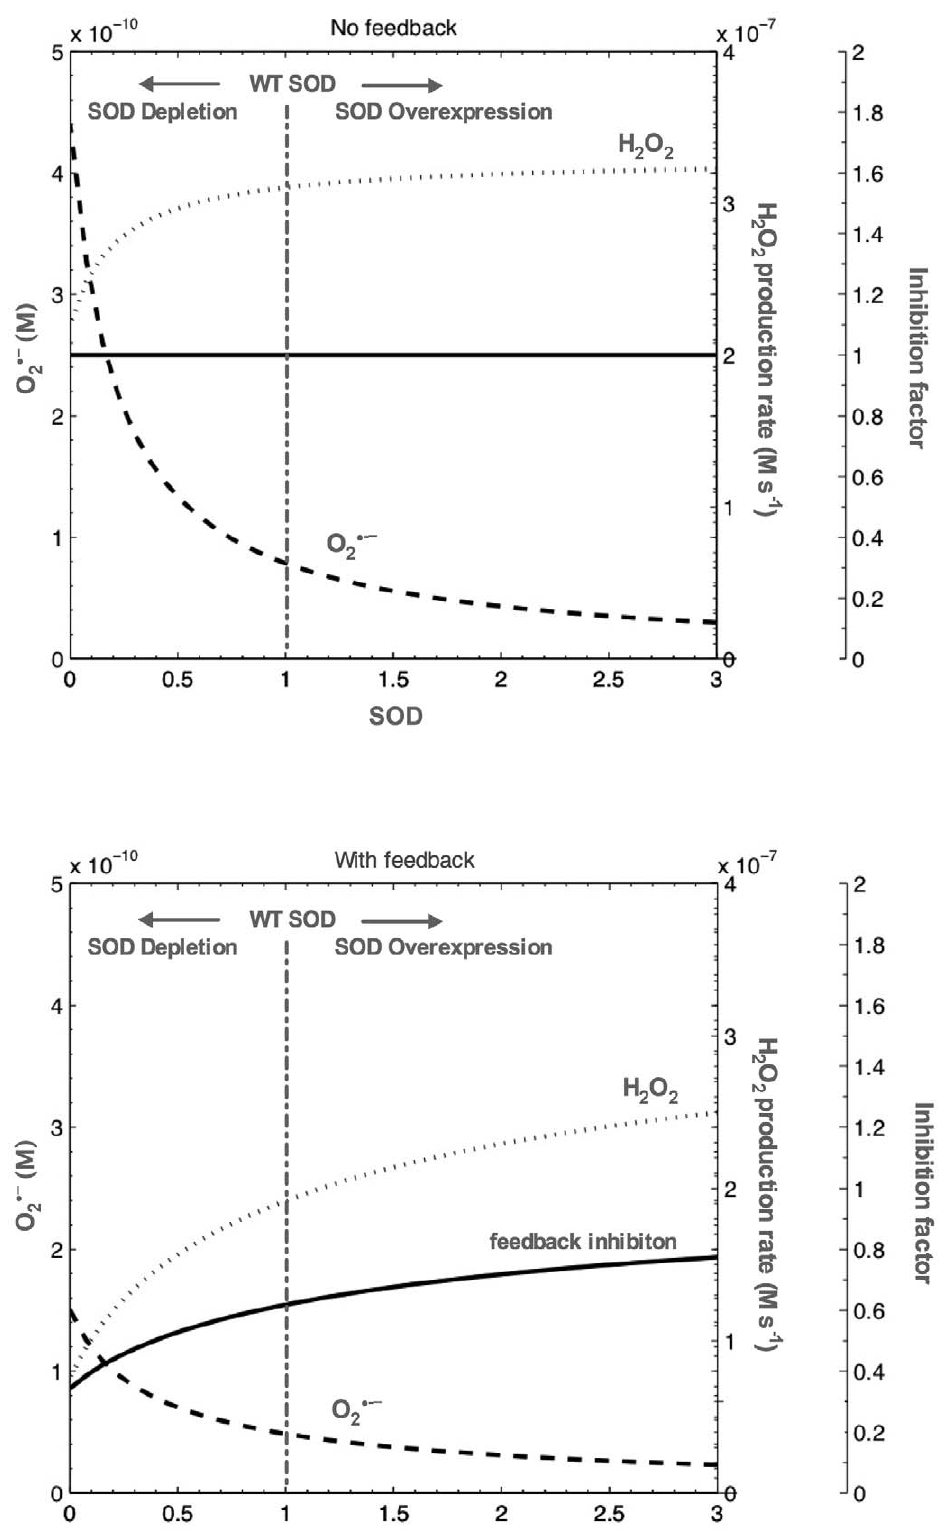
Figure 8. Results of SOD knockdown/deletion or overexpression according to the model. Model results showing dependency of mitochondrial superoxide level, hydrogen peroxide production rate and feedback inhibition factor (decrease in energy production relative to n=0 case) on mitochondrial SOD without feedback (top, n=0) and with feedback inhibition (bottom, n=1). WT levels of mitochondrial SOD are normalised to 1 and indicated by the vertical dashed line. The area to the right of WT levels reflects SOD overexpression while the area to the left reflects SOD depletion, with complete knockout corresponding to zero SOD. Note that hydrogen peroxide production rate increases monotonically